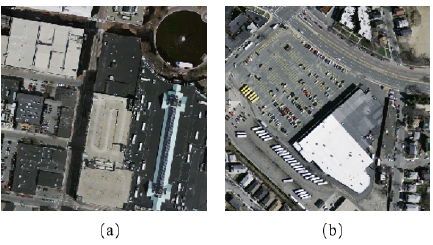
Figure 4. Two typical types of buildings in the Massachusetts Building Dataset: ( a ) the building with different tones and textures; and ( b ) the building with complex